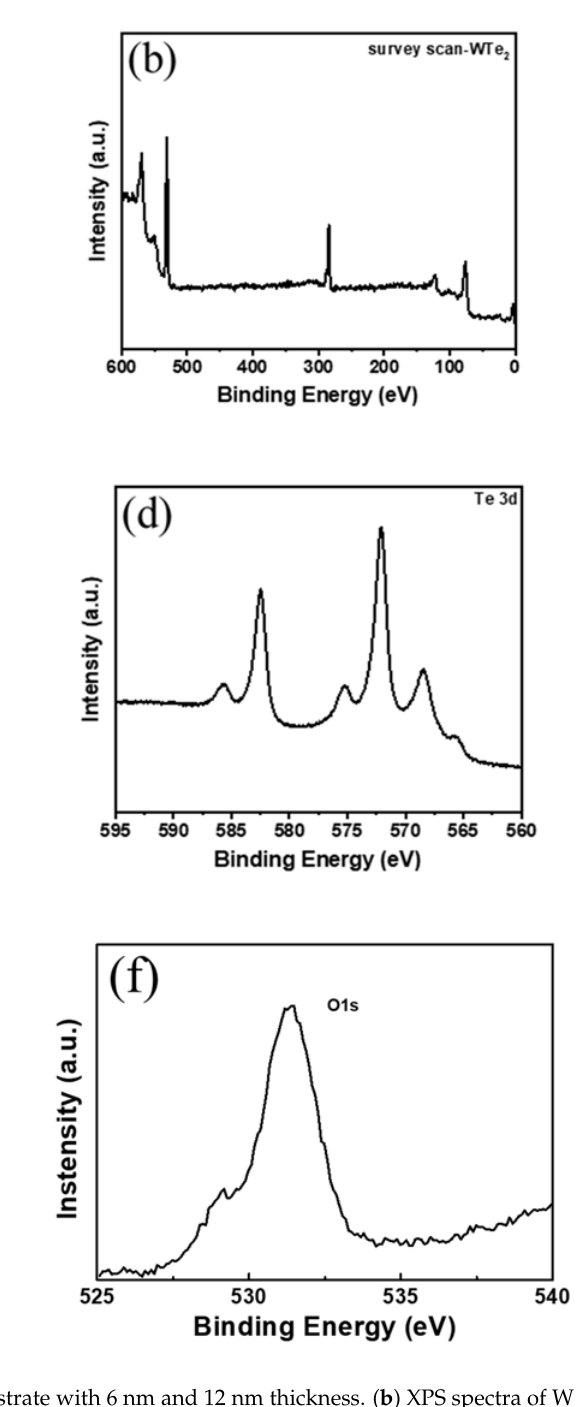
Figure 2. ( a ) Raman Spectroscopy of WTe 2 on a flexible PET substrate with 6 nm and 12 nm thickness. ( b ) XPS spectra of W and Te elements in WTe 2 films. ( c ) W 4f level and ( d ) Te 3d level in WTe 2 films indicating the presence of non-stoichiometric WO x films under the influence of reactive Ag top electrode. ( e , f ) The XPS analysis from the surface of the SnO 2 depicting the Sn3d and O1s peaks.